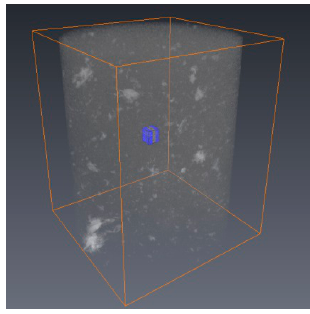
Figure 7. Data cube selected in the reconstructed digital coal body.